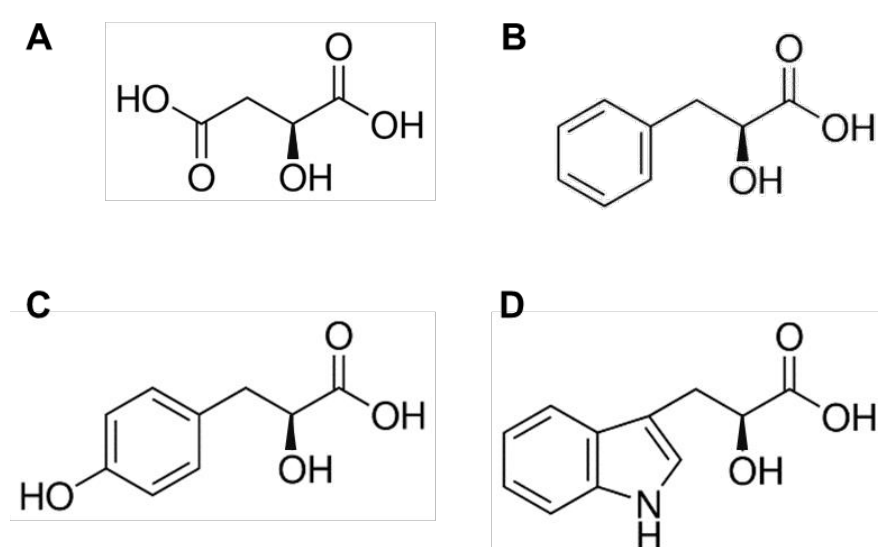
Figure 2. Hydroxy-analogs of Psy ArAT substrates: ( A ) L-malic acid (DOH, MLT); ( B ) L-3-Phenyllactic acid (FOH, HFA); ( C ) L-p-Hydroxyphenyllactic acid (YOH, TYF); ( D ) L-3-indolelactic acid (WOH; 3IL).